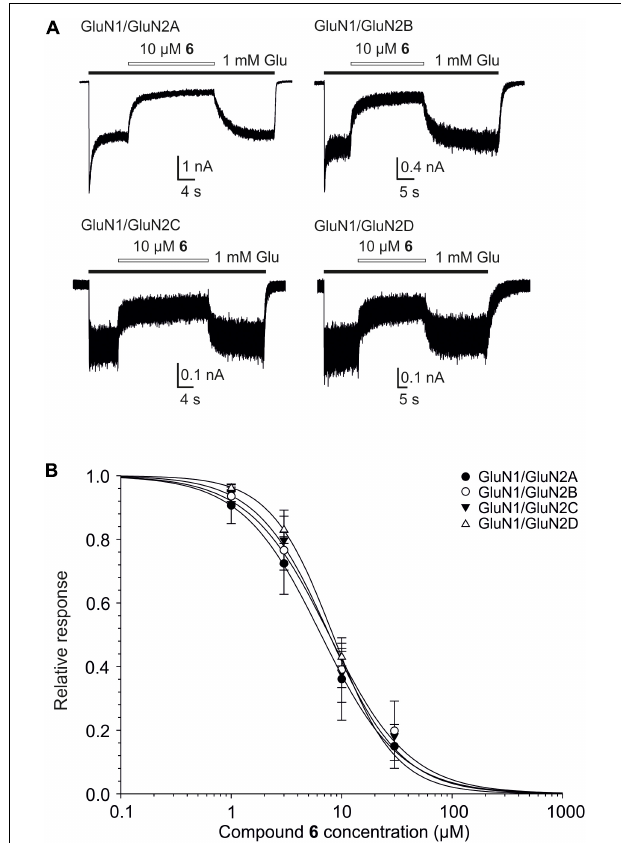
FIGURE 7 | Concentration–response properties of compound 6 on GluN1/GluN2A-D receptors. (A) Examples of traces obtained from HEK293 cells transfected with cDNAs encoding GluN1/GluN2A, GluN1/GluN2B, GluN1/GluN2C, and GluN1/GluN2D receptors. Agonists (1 mM glutamate and 10 µ M glycine) were applied alone and simultaneously with compound 6 (10 µ M) to evaluate the inhibitory effect of compound 6 on NMDAR mediated currents (duration of glutamate and steroid application is indicated by filled and open bars, respectively). (B) Concentration–response curves for the compound 6 effect at GluN1/GluN2A-D receptors. Data points are averaged values of normalized responses from at least four HEK293 cells. Error bars represent SD. The relative agonist induced responses ( I ) recorded in the presence of compound 6 (1–30 µ M) and determined in individual cells were fit to the following logistic equation: I = 1/(1 + ([ steroid ]/IC 50 ) h ), where IC 50 is the concentration of steroid that produces a 50% inhibition of agonist-evoked current, [ steroid ] is the steroid concentration, and h is the apparent Hill coefficient.